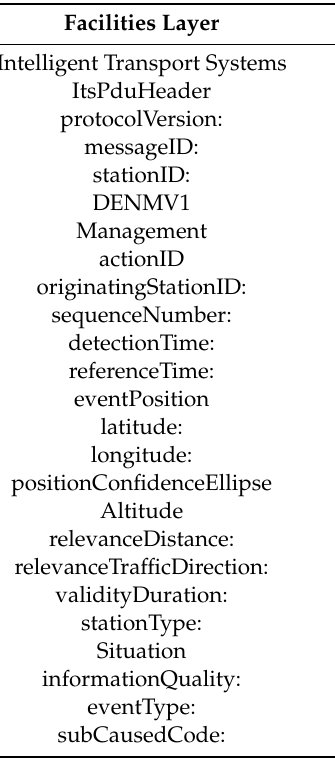
Table 1. Intelligent transport system (ITS-G5) Facilities layer fields.